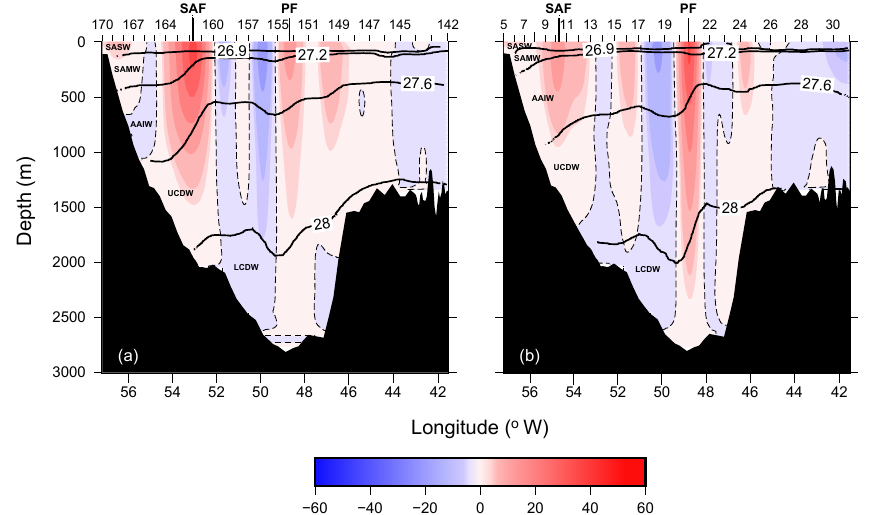
Figure 3. Geostrophic velocity (cms − 1 , positive northward) relative to the bottom for (a) the ALBATROSS cruise and (b) the MOC-Austral cruise. Black dashed lines mark 0cms − 1 velocities. Thick black lines stand for the representative isoneutrals (26.90, 27.20, 27.60 and 28.00kgm − 3 ) defining the water masses in the region. Station numbering and the front (SAF and PF) location are displayed on the top